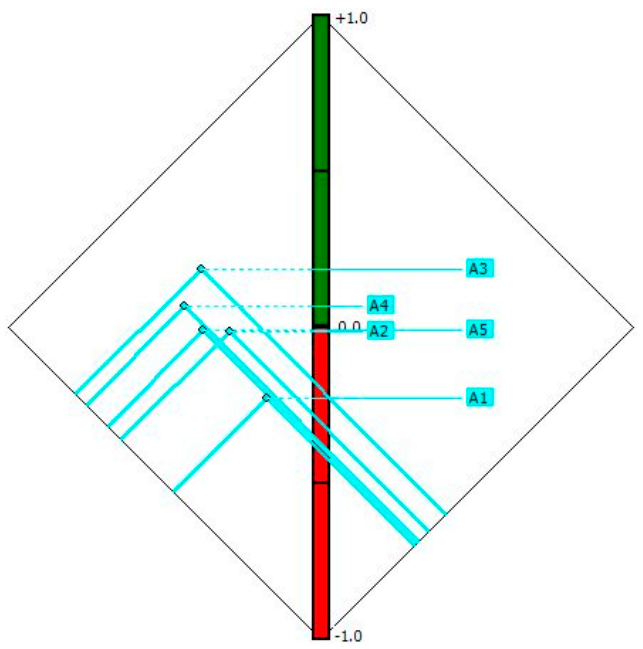
Figure 4. PROMETHEE diamond solutions. Tailings—A1-Žarkov Potok; A2—Gornje Polje; A3— Žitkovac; A4—Tvr đ anski Do; A5—Bostanište.